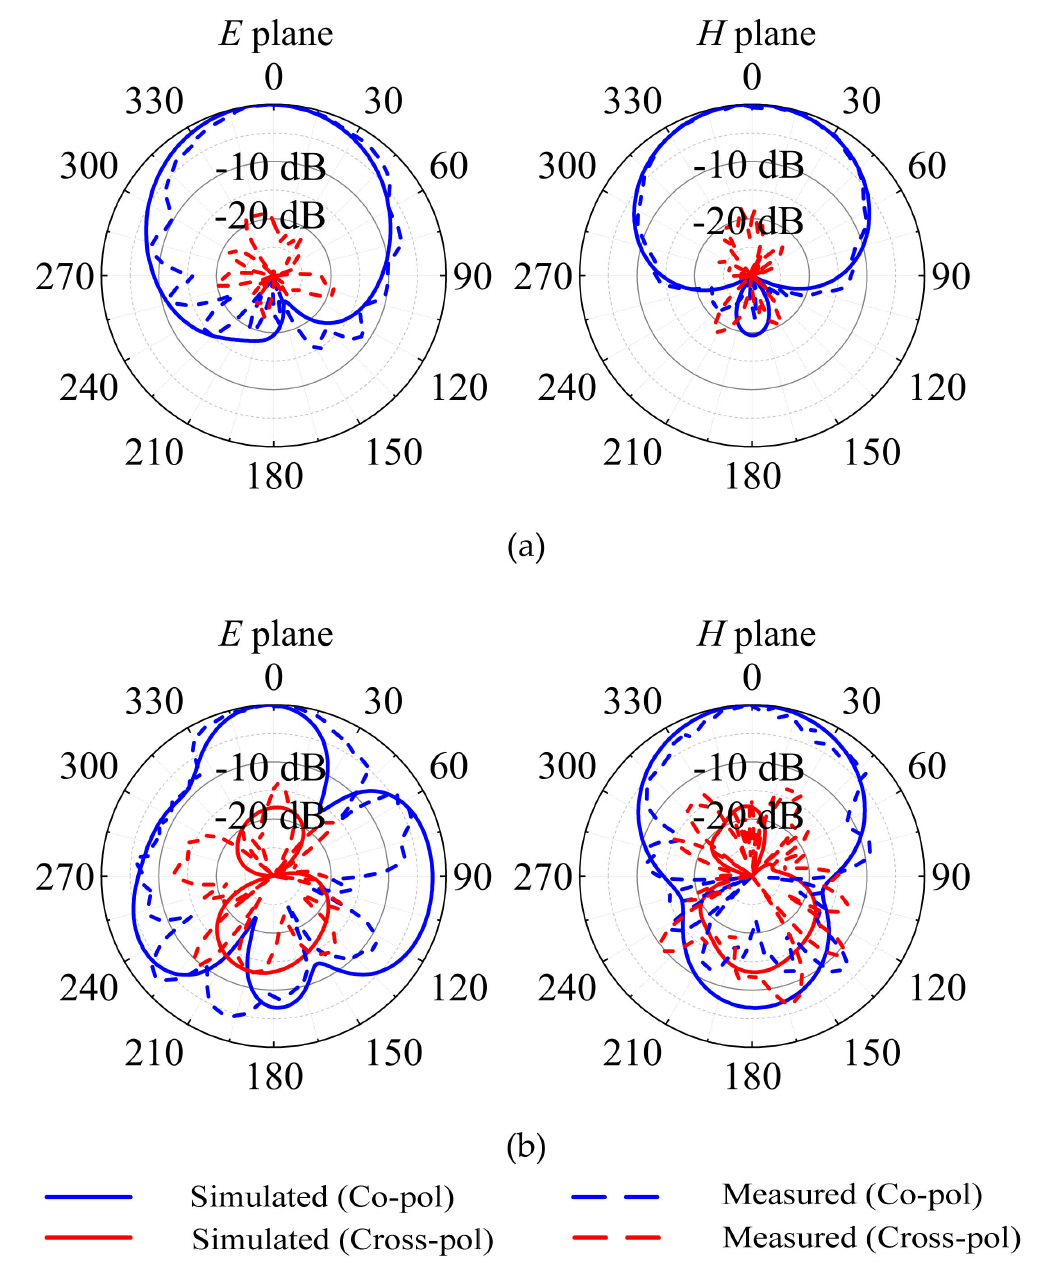
Figure 7. Simulated and measured radiation patterns of the proposed design at excitation port 1: ( a ) at 3.5 GHz; ( b ) at 4.9